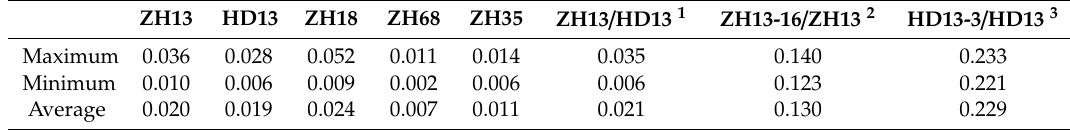
Table 2. The pairwise patristic distances of the plants from the same